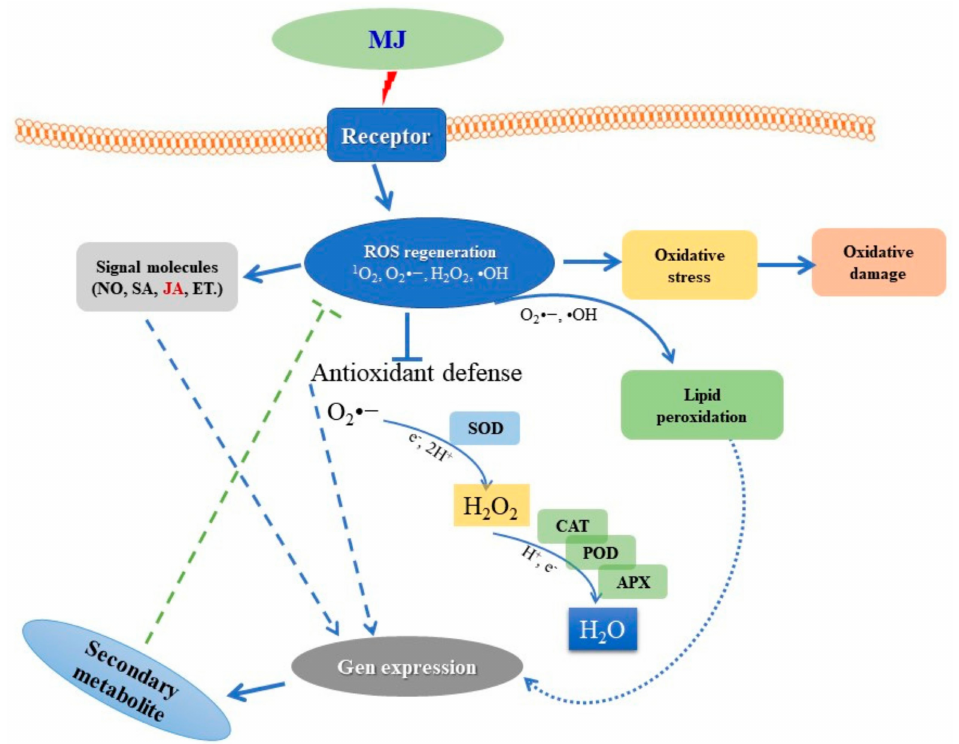
Figure 3. General mechanism after MJ perception. Abbreviations: ROS reactive oxygen species,